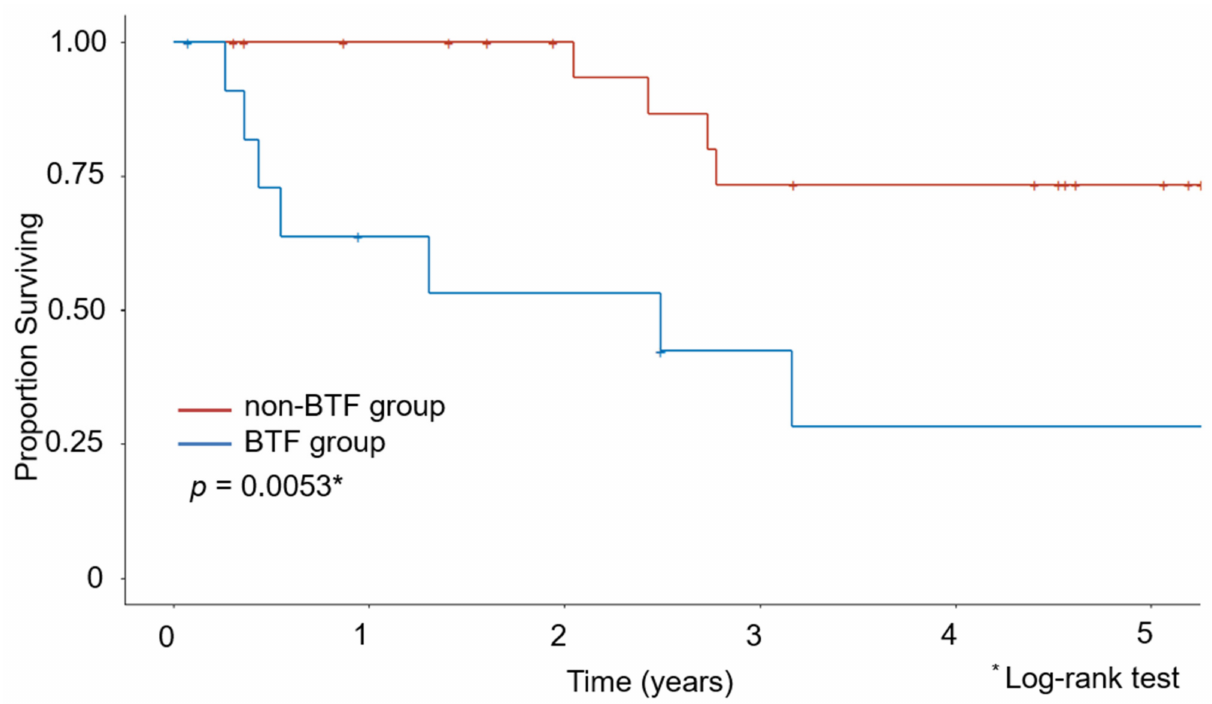
Figure 2. Kaplan–Meier estimates of overall survival after excluding patients who underwent minimally invasive